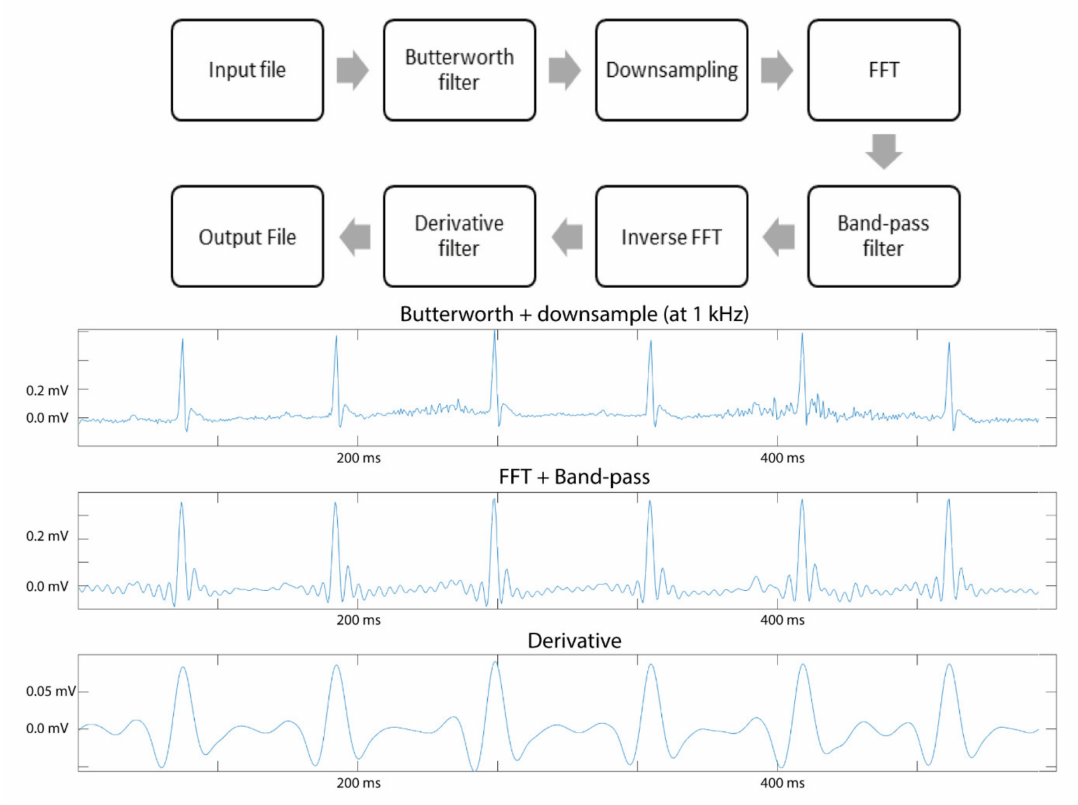
Figure 3. Schematic representation of the di ff erent pre-processing steps applied to the input file and resulting e ff ect on the ECG trace. FFT; Fast Fourier